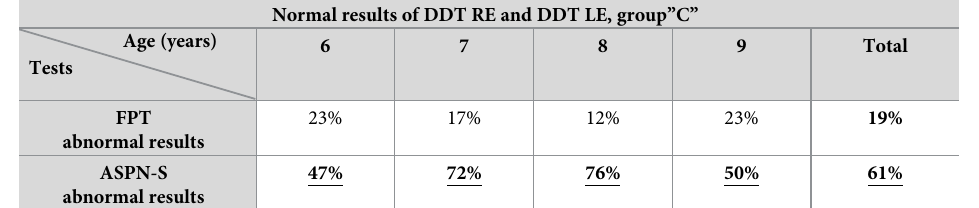
Table 5. Percentage of abnormal FPT and ASPN-S test results with normal DDT RE and DDT LE results, in group”C”, by age.